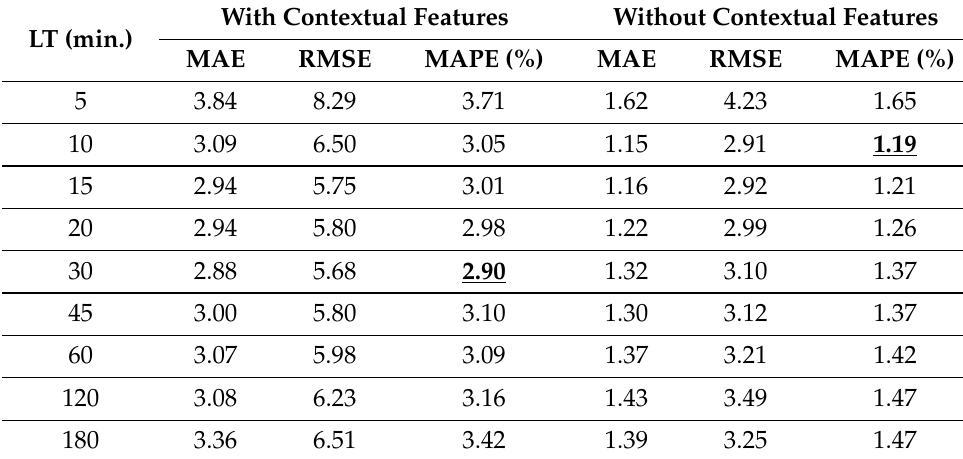
Table 7. The effect of LT and contextual features on LSTM models. LT